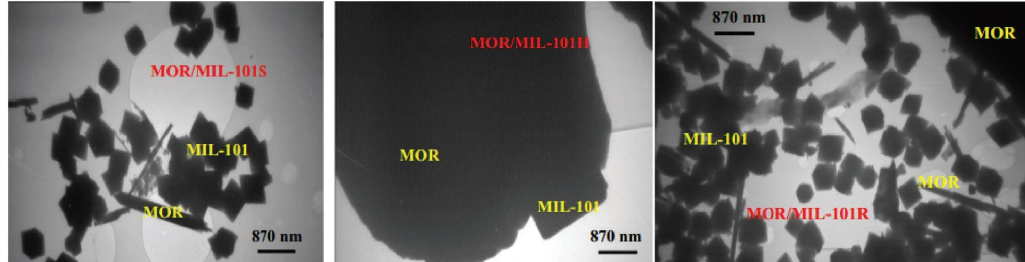
Figure 24: TEM images of MOR@MIL-101 (Cr) compounds adopted from